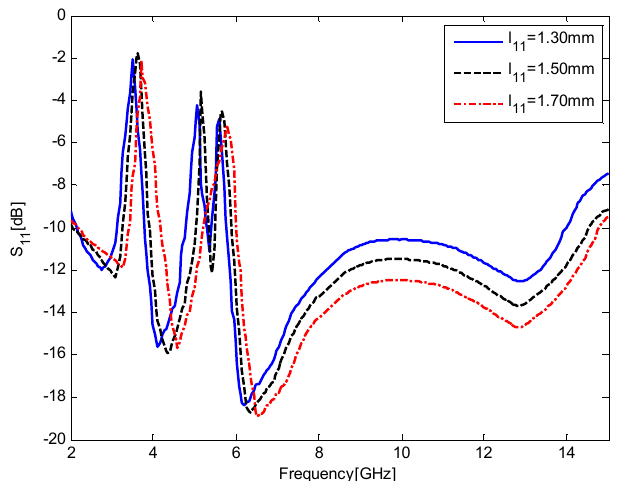
Figure 7. Simulated S 11 results for the antenna as a function of l 11 , the height of the ground plane.